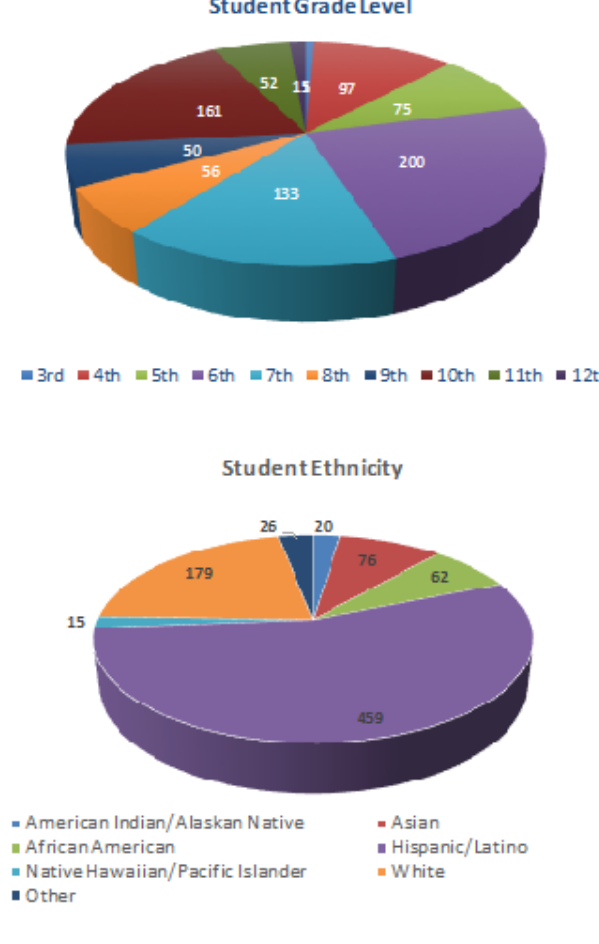
Figure 4. Student participant grade level and